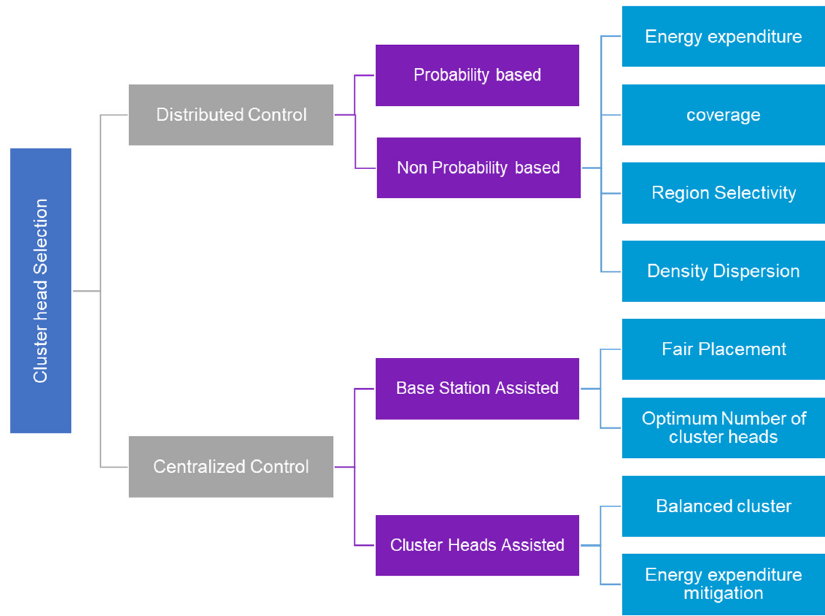
Figure 6. Cluster head selection